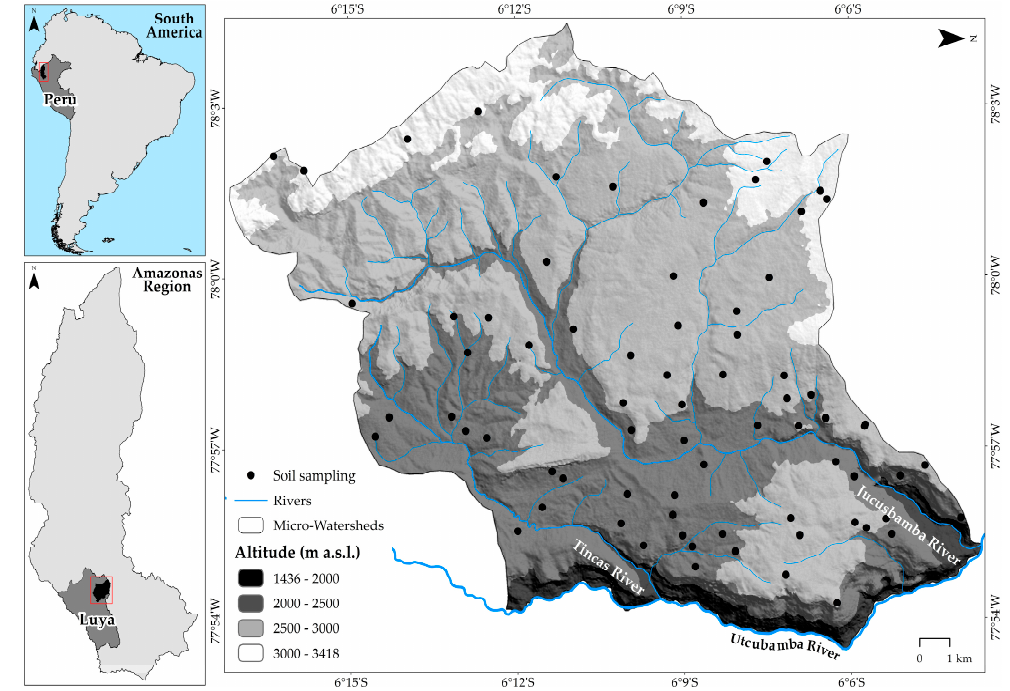
Figure 1. Location of the Jucusbamba and Tincas microwatersheds in the province of Luya, Amazonas (NW Peru).